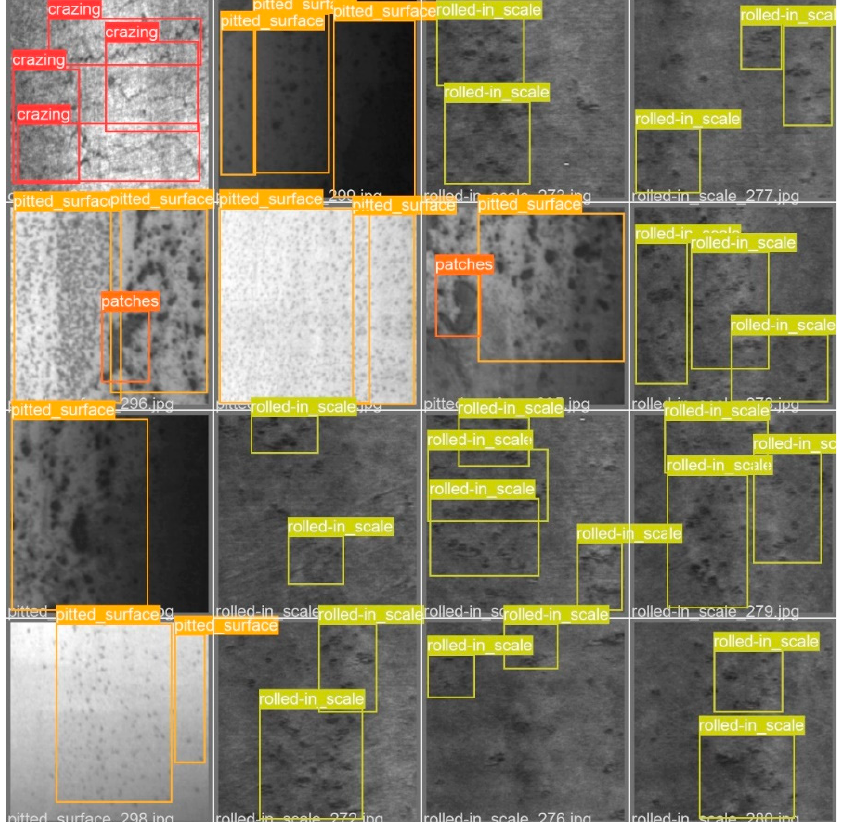
Figure 8. Detection results of defects in the NEU-DET dataset by the proposed algorithm.